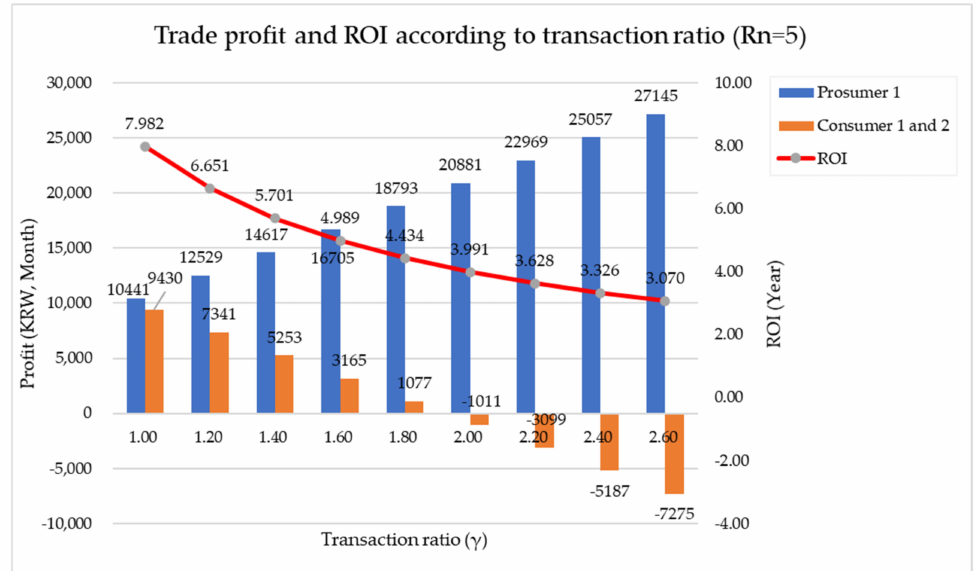
Figure 17. Transaction profit and ROI of Model 2 according to the change in γ